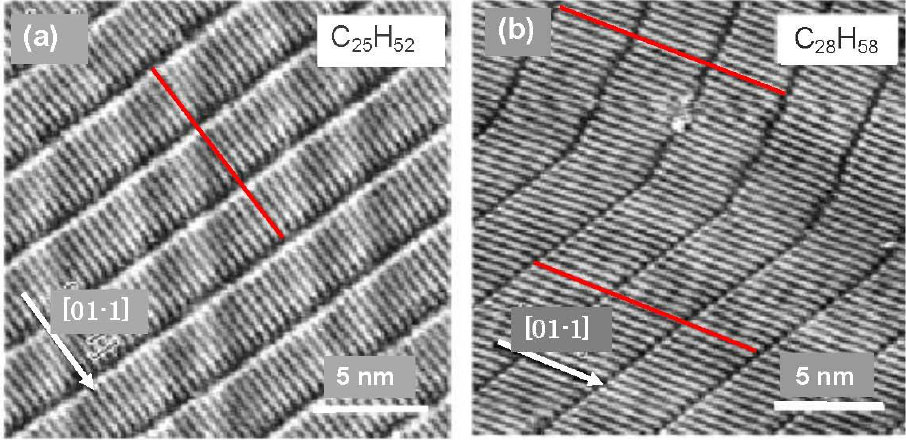
H ), whereas it is ca. 120° with respect to the molecular axis in 25 52